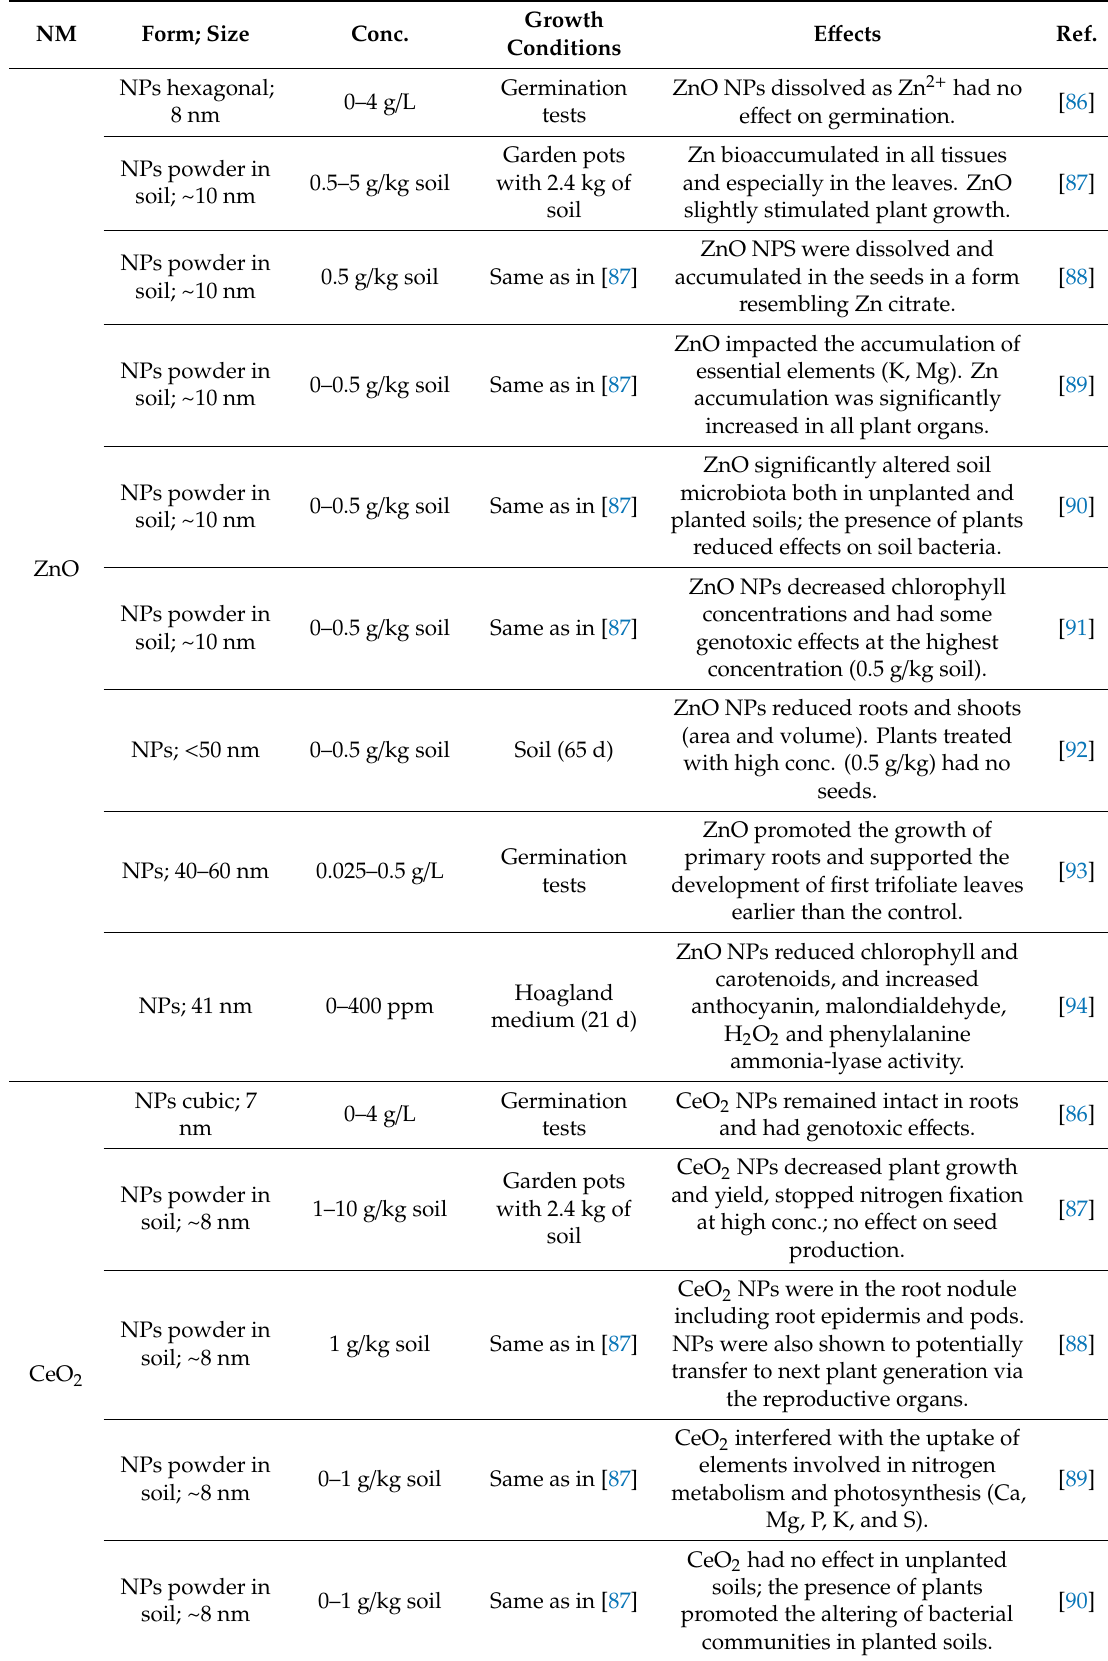
Table 1. Soybean interaction with various